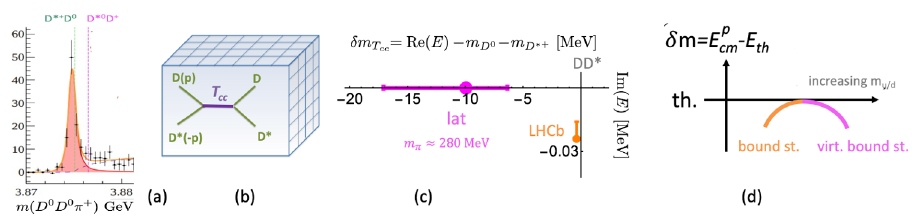
Figure 11. (a) The LHCb discovery of the doubly-charmed tetraquark T cc [50]; (b,c) The lattice sim- ulation [51] of DD ∗ scattering renders a virtual bound state pole below the threshold, likely related to T cc . (c) A sketch of T cc binding energy as a function of m u / d according to a simple toy model